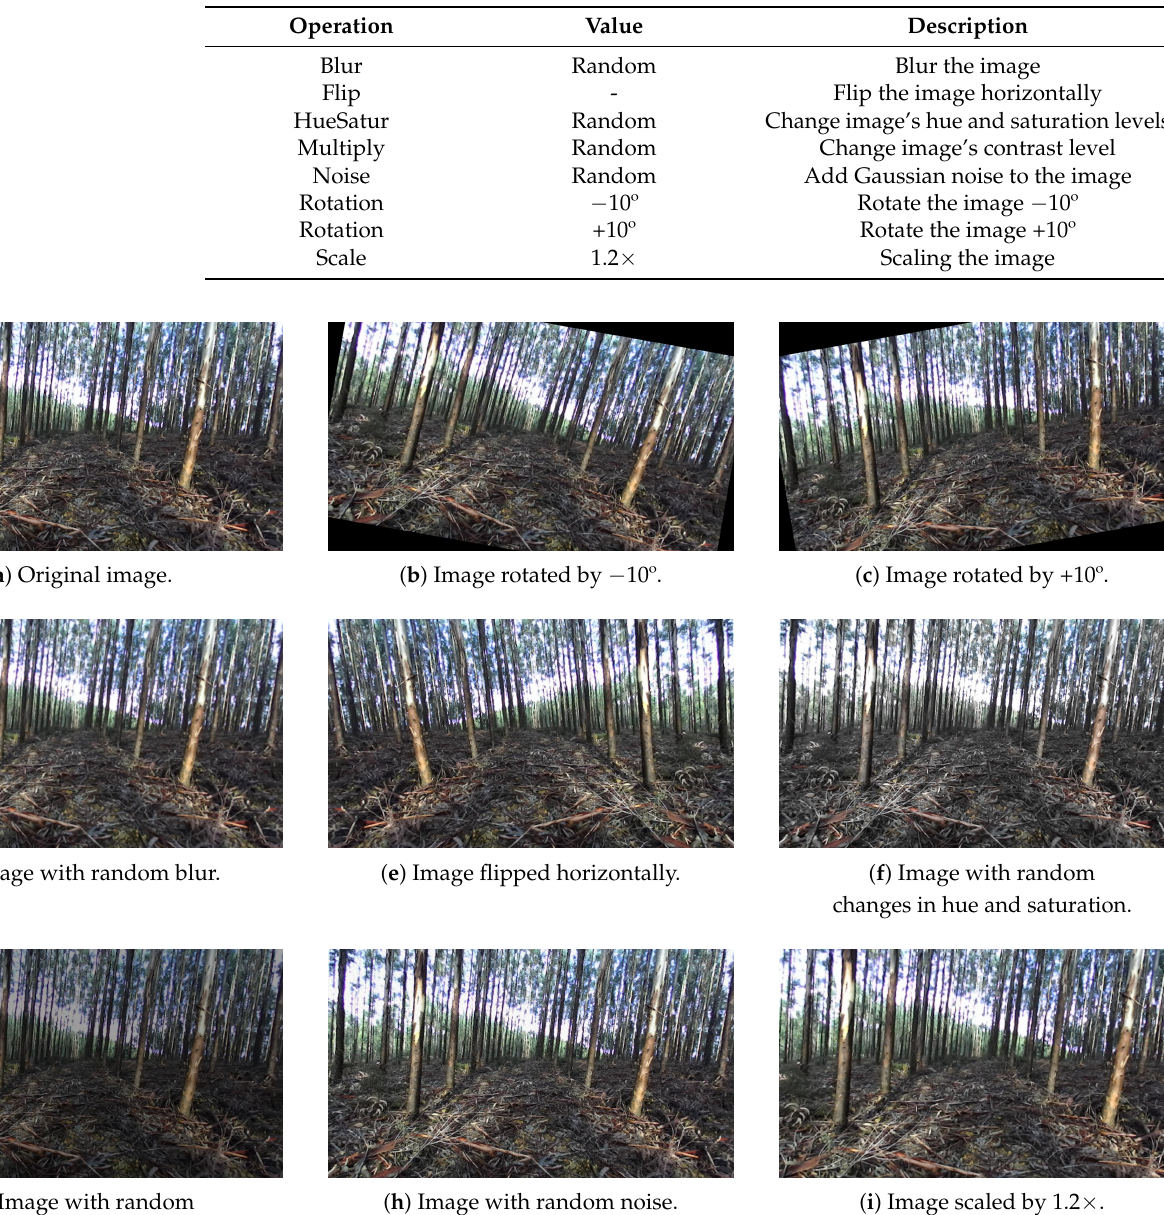
Table 2. Augmentation operations.